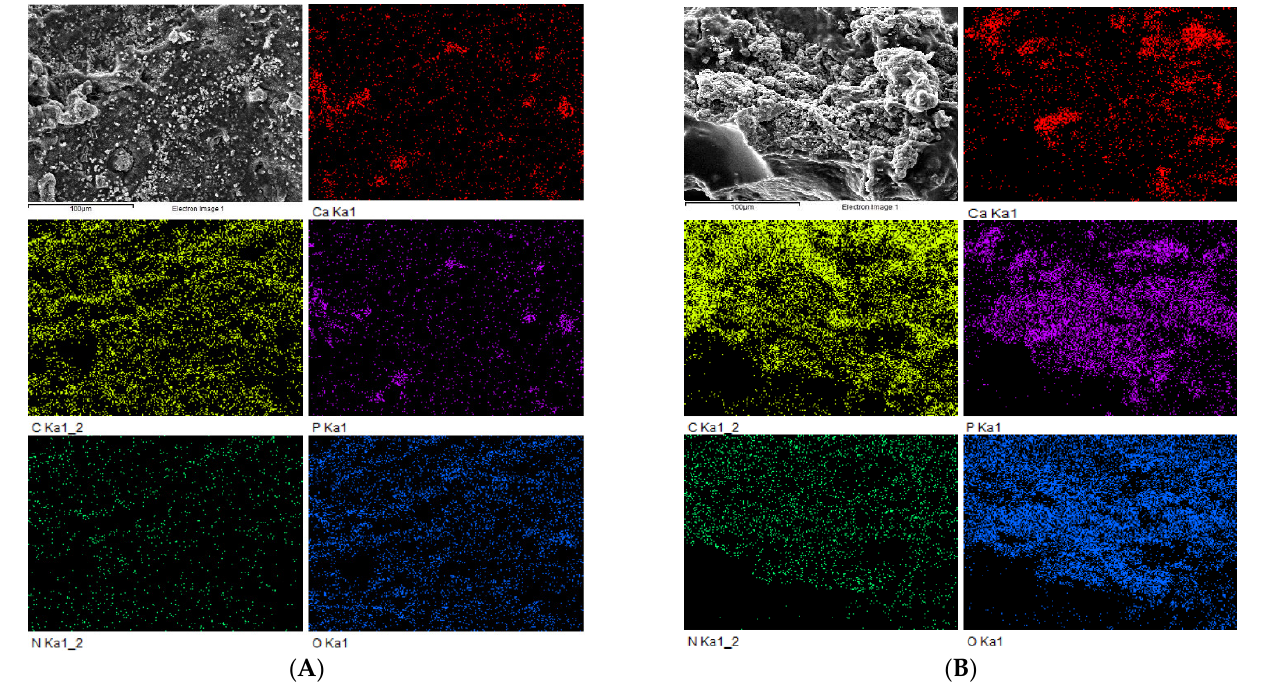
Figure 6. The scanning electron microscopy images (SEM) with energy-dispersive X-ray spectroscopy (EDS) mapping analysis, which were used to evaluate the distribution of hydroxyapatite-based hydrogel before ( A ) and after immersion ( B ) with simulated body fluid (SBF) for 14 days.